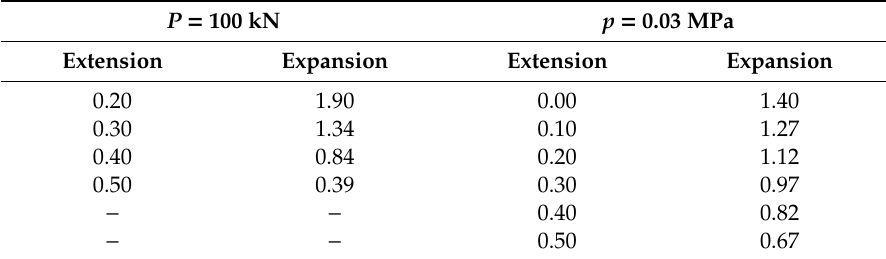
Figure 7. Possible deformation under specific axial force. Table 2. Possible deformation data under specific